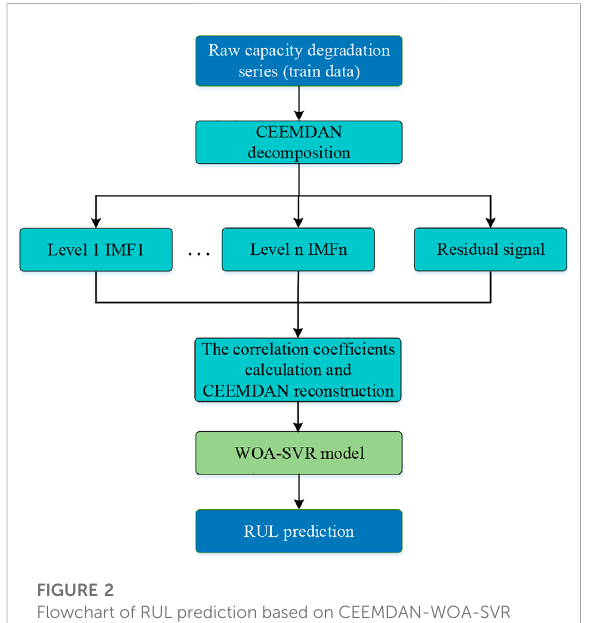
FIGURE 2 Flowchart of RUL prediction based on CEEMDAN-WOA-SVR method.